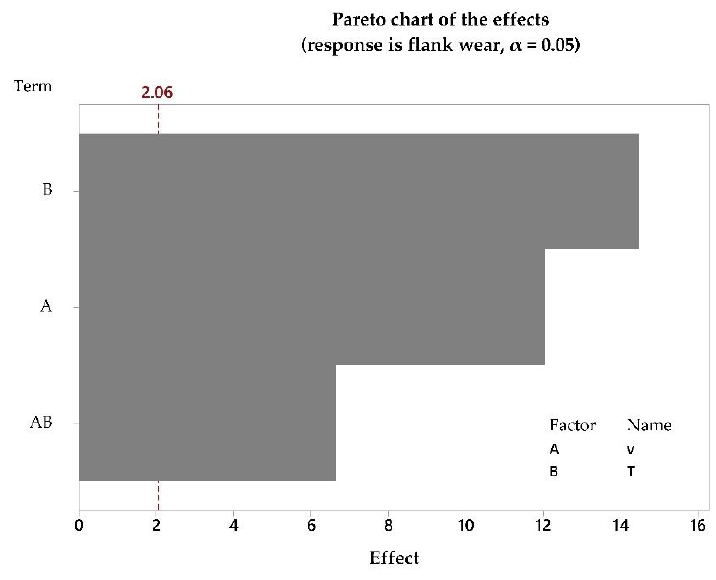
Figure 4. Pareto graphic of variable effects on flank wear, for the GC4215-P15 insert.